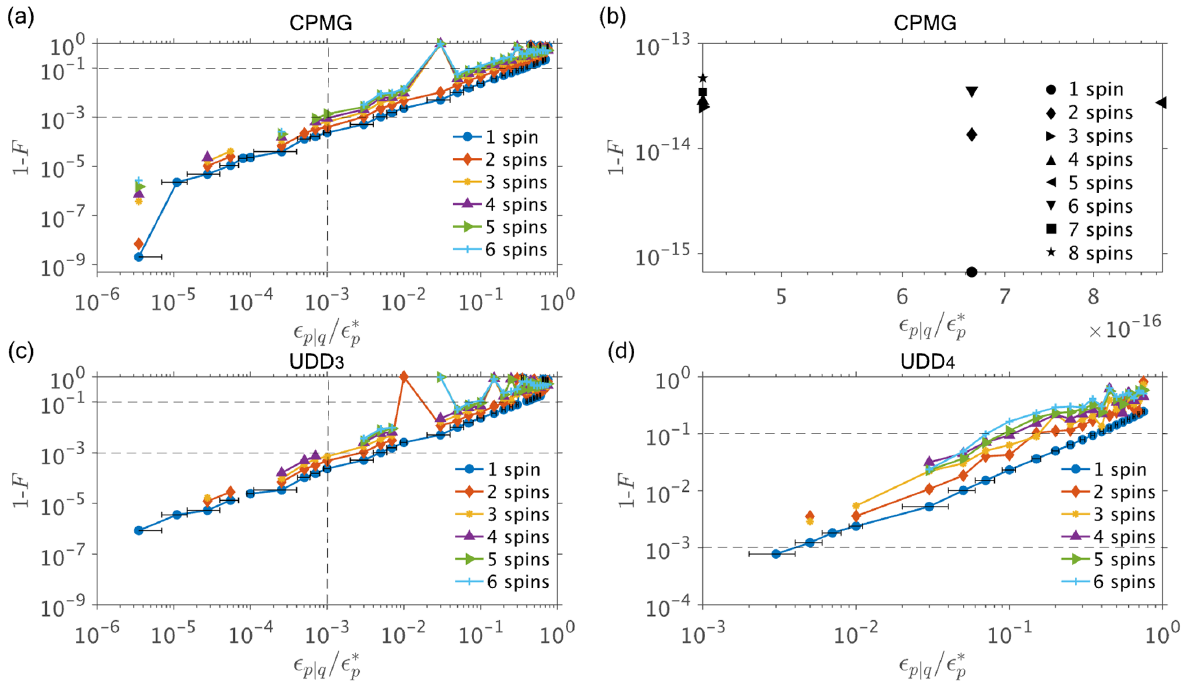
2 = 9 ) of unwanted nuclear spins for (a),(b) FIG. 7. Gate error 1 − F as a function of one-tangles (scaled by the maximum value ϵ (cid:3) p ¼ the CPMG, (c) the UDD 3 , and (d) the UDD 4 sequences. The labels in all graphs show up to how many spins are “ traced out ” from the total system. The unwanted spins have one-tangles in the range [0,0.76]. The error bars of the blue points show the intervals of one- tangles to which we assign unwanted spins and are the same for all differently colored lines. For one-tangle bins where we cannot find up to six distinct sets of HF parameters, we include data only up to a smaller number of unwanted spins for which distinct sets can be found. In (b), we use the condition for the trivial evolution to identify unwanted nuclei which do not introduce any gate error. The dashed lines in the plots serve as a guide to the